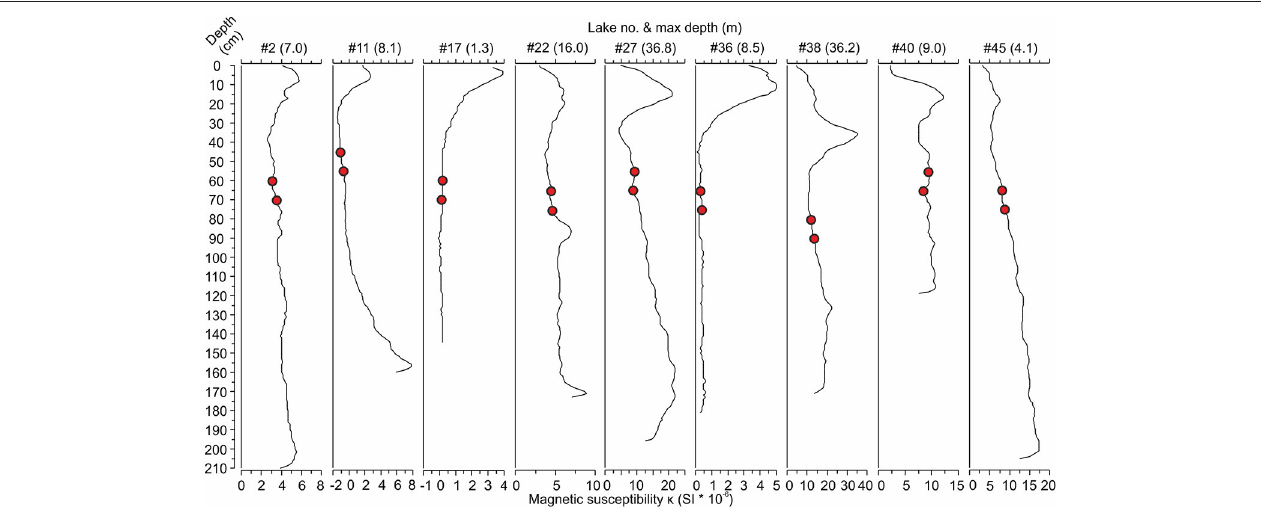
FIGURE 2 | Examples of magnetic susceptibility profiles from nine lakes [#lake number (max lake depth)] showing the increases in magnetic susceptibility toward the present day (core top). The red circles represent the bottom samples taken at 20 and 30cm below the rise in magnetic susceptibility indicating the start of anthropogenic catchment erosion. See Table 1 for the names and locations of the lakes.